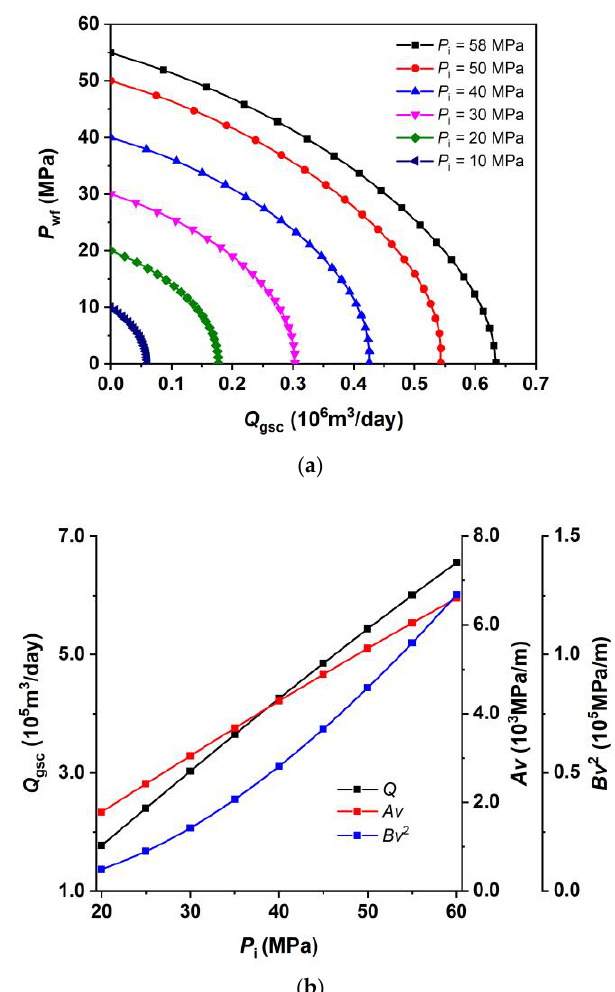
Figure 8. Effect of original reservoir pressure on gas production rate and flow characteristics. ( a ) IPR curves with different original reservoir pressure. ( b ) Characteristic analysis of flow regime at the well bottom hole.